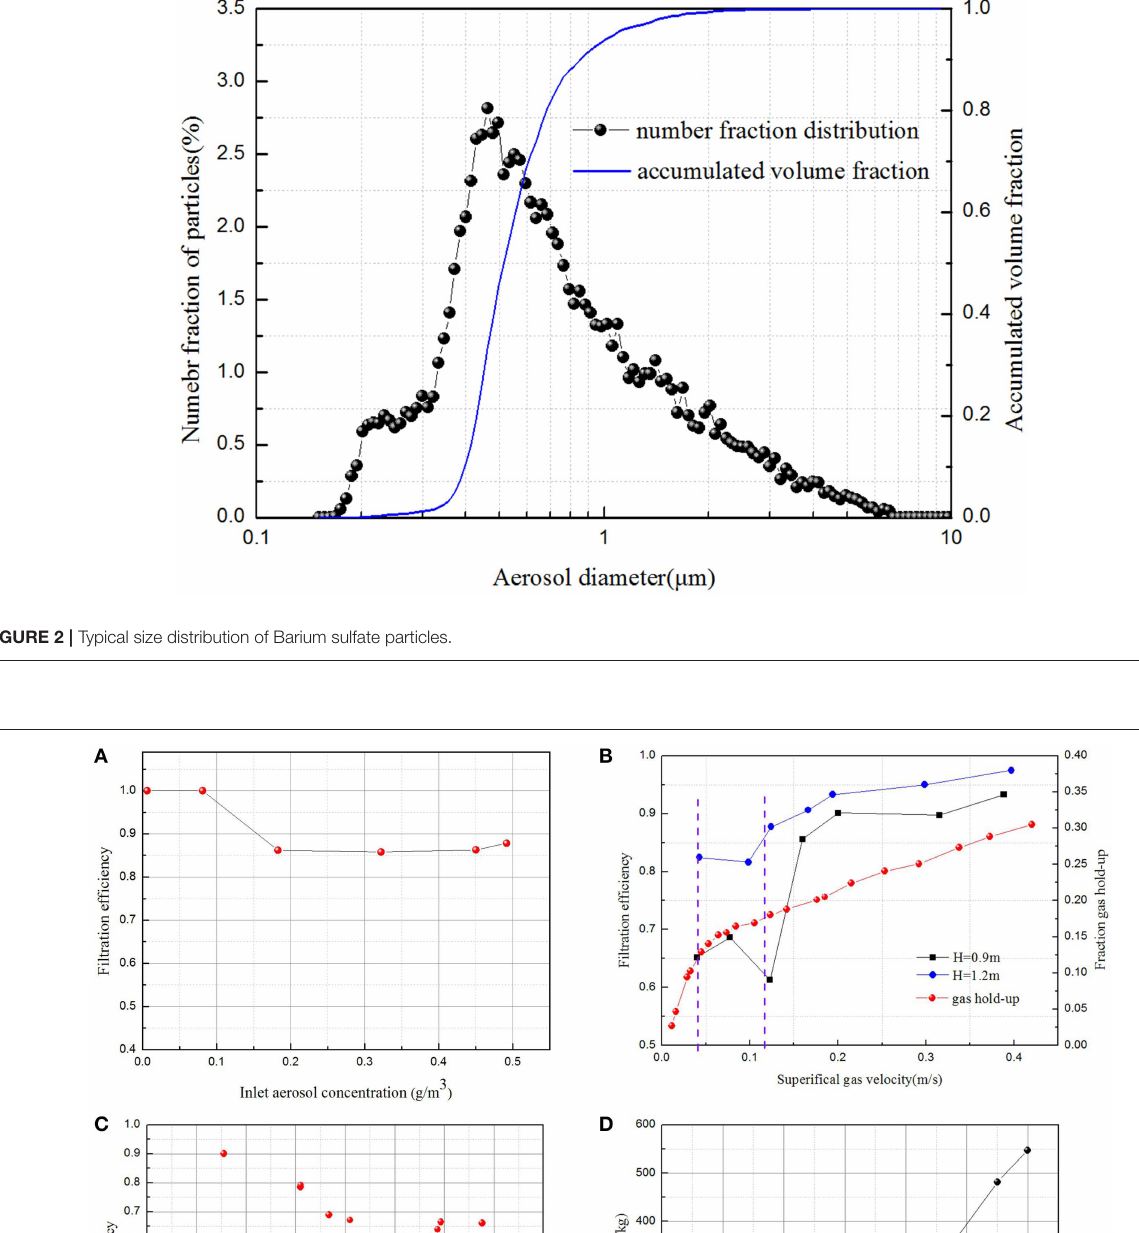
Frontiers in Energy Research |